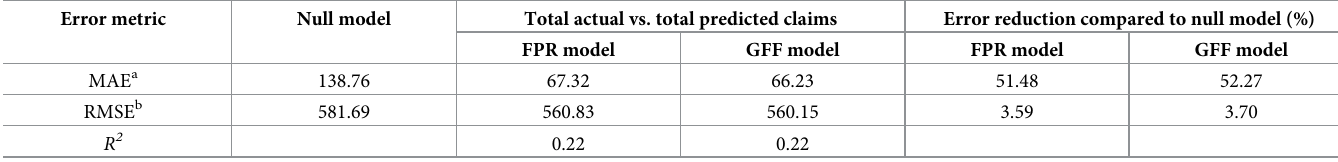
Table 6. Comparison of the total actual number of claims from actual events versus the total predicted number of claims from predicted events using the state-level analysis in 2016 at the county level. Error metric